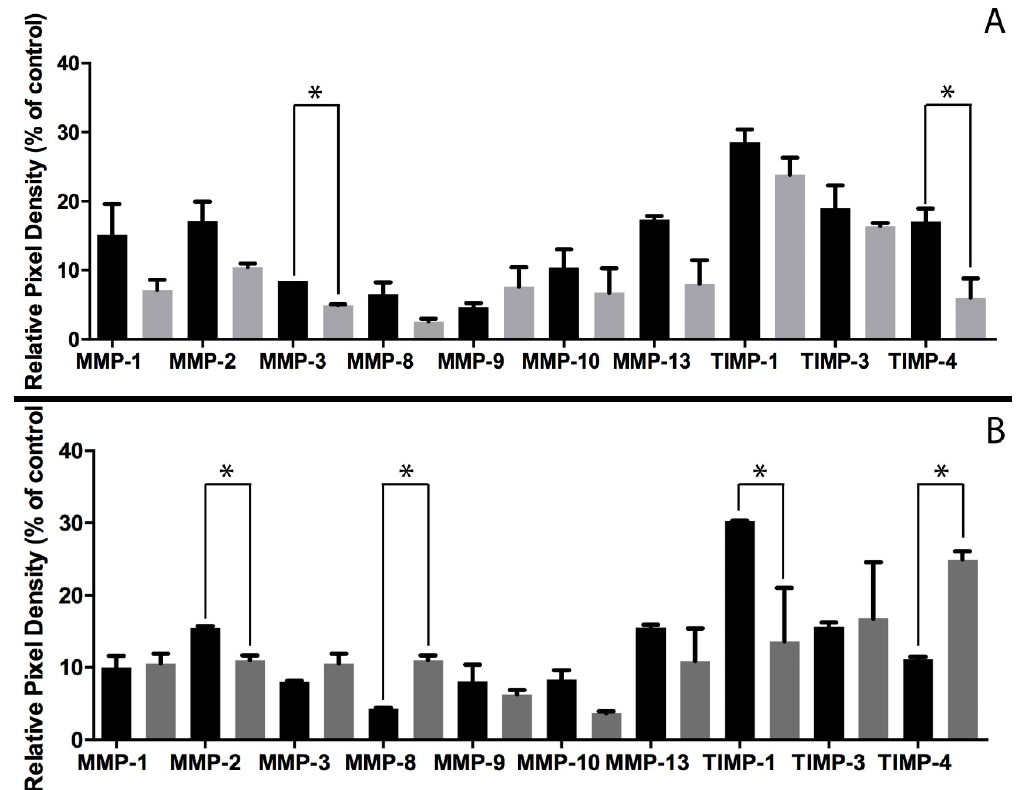
Figure 7. MSC spheroid MMP and TIMP secretion into culture medium at 3 h (black) and 72 h (grey). ( A ) Standard media and ( B ) DMEM with 1 ng/mL IL ‐ 6. Protein array membranes viewed using Agilent 2100 Bioanalyser, followed by quantification using ImageJ. Values analysed via t ‐ test, * p <